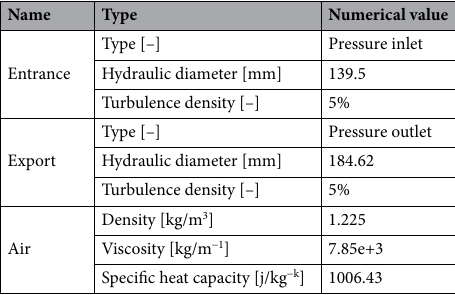
Table 2. FLUENT simulation parameter settings.